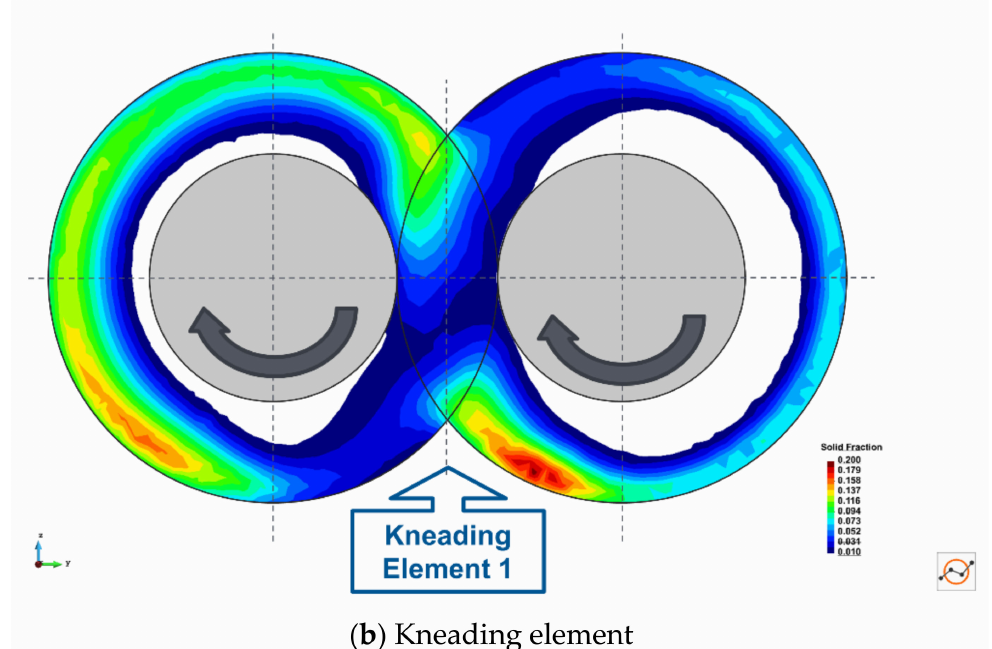
Figure 7. Transport locations in different element types. The Residence Time Distribution (RTD) for the full TSG simulation was extracted, which shows a mean total residence time of approximately 3 s. This is in the region of what has been measured experimentally for a free-flowing material in similar equipment [7,27,28,39]. RTDs for the full-size DEM simulation and the periodic simu- lation in the same domain, over a 1 s period at steady state, are compared in Figure 8. The periodic simulation is capturing the same behaviour as the full-size simulation. For the total residence time, the periodic results include a spike at 0 s, which is an artefact due to the re-circulation of particles through the periodic domain and the time they spend in the buffer zone at each end. The agreement is also excellent for the RTDs by element